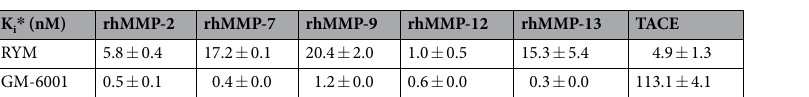
Table 1. Inhibition constants (K i ) of RYM and GM 6001. * K i values represent the mean ± SD of three